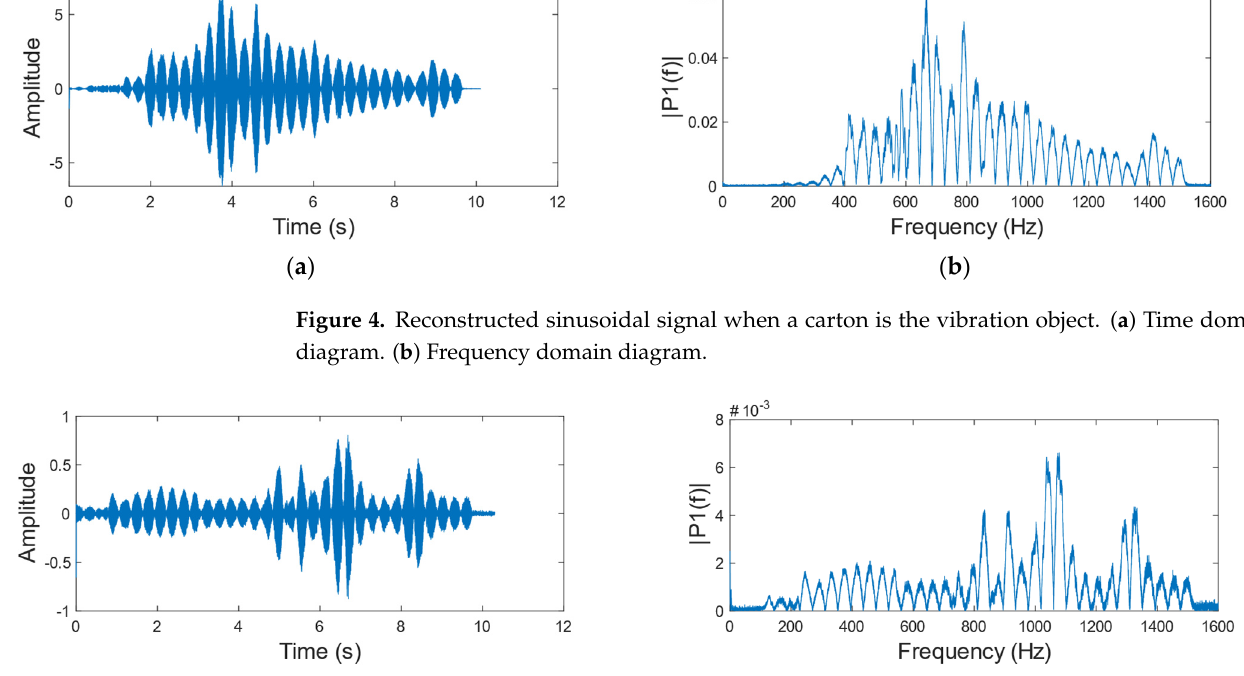
Figure 3. Original sinusoidal signal. ( a ) Time domain diagram. ( b ) Frequency domain di ‐ agram.